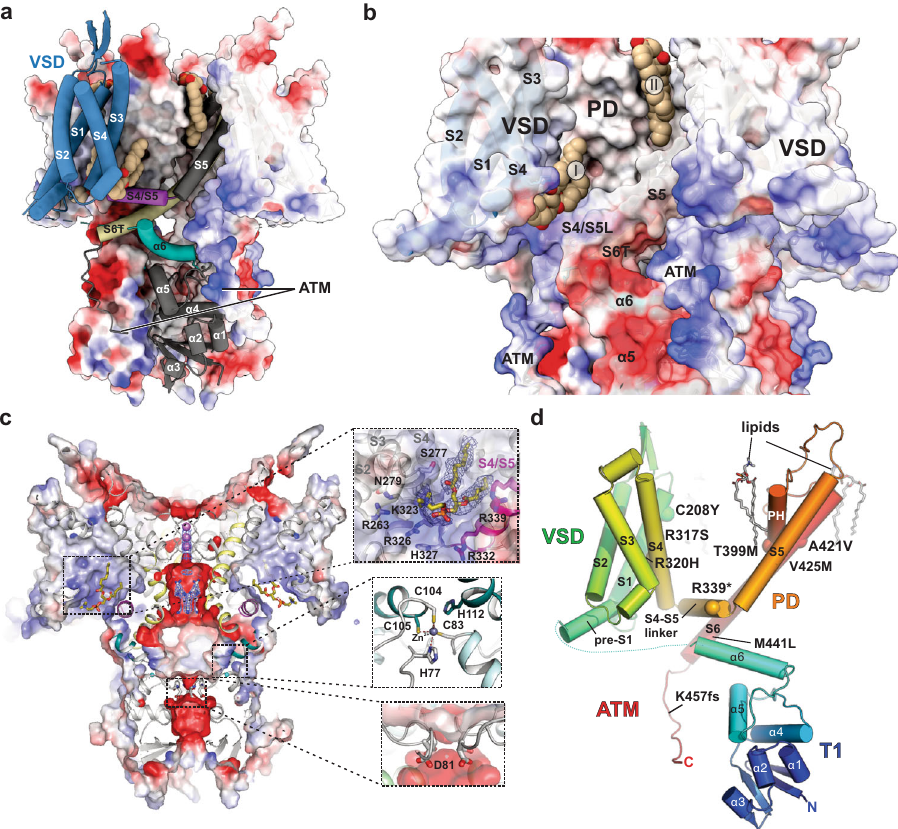
Fig. 2 Electrostatic surface properties and location of disease mutations. a Electrostatic surface representation of the Kv3.1a tetramer with a single protomer shown as cartoon, highlighting the relative arrangement of VSD (blue), S4/S5 linker (magenta) and α 6 (teal) of the T1 domain. Lipids are shown in brown space- fi ll representation. The surface is coloured by electrostatic potential (red, − 5 kT e − 1 ; blue, + 5 kT e − 1 ). b Enlarged view of the Kv3.1 tetramer in full surface representation, highlighting electrostatic attraction between negatively charged α 5 and α 6 in T1 (red surface areas) and positively charged ATM (blue surface areas). Two lipid-binding sites are shown: site I between S4 and S4/S5 linker and site II at the interface between VSD and PD. c Slab view of ( a ) with insets 1. highlighting residues involved in lipid interactions at site I, 2. the interfacial Zn 2 + binding site in T1 and 3. the lower constriction in T1 with D81 as major player for negative surface potential and local K + ion abundance. d Kv3.1a protomer in cartoon representation with c α atoms of residues implicated in disease mutations shown as spheres. Lipids are shown in stick